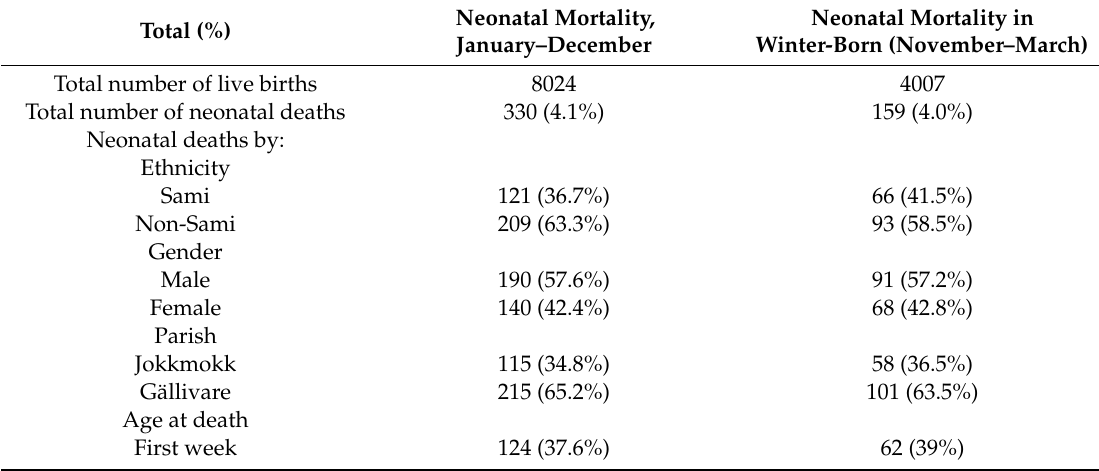
Table 2. Descriptive statistics of population data,